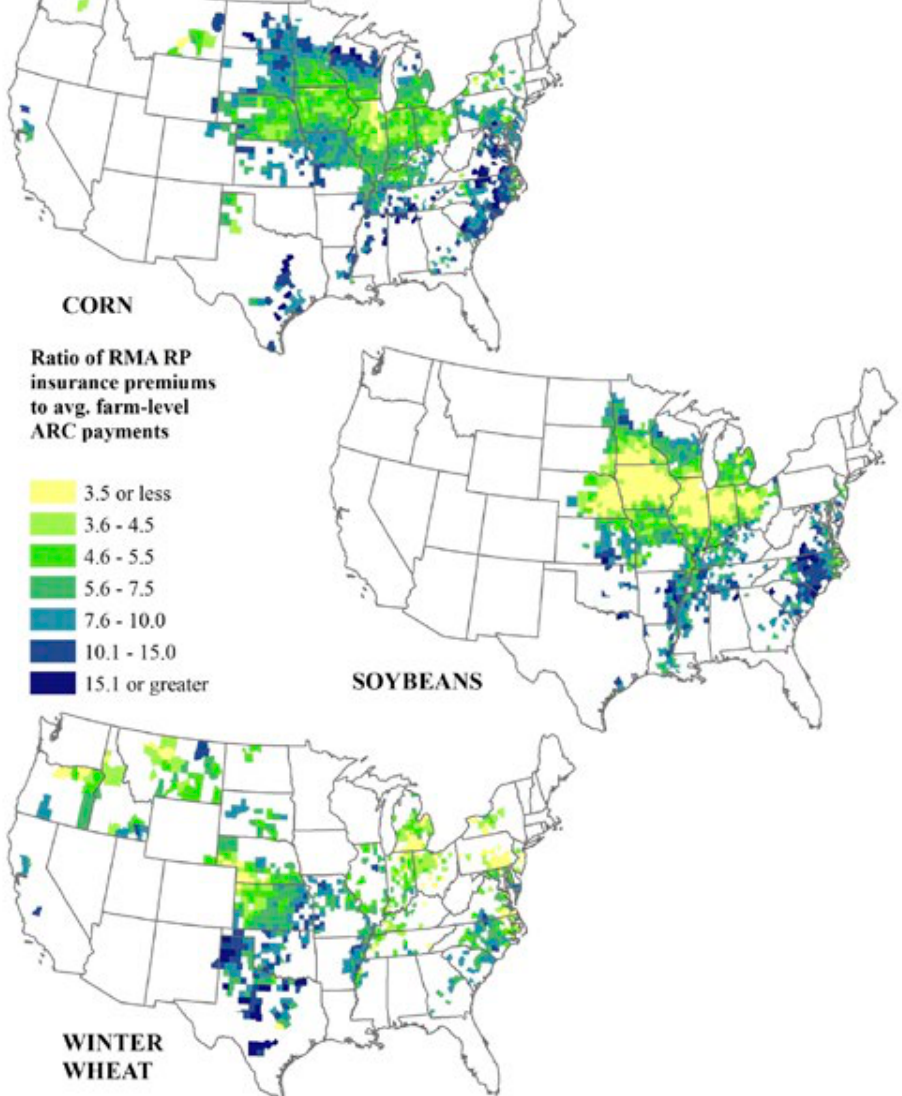
Figure 2. Ratio of Federal RP crop insurance premiums to farm level ARC payments for a representa- tive farmer in each